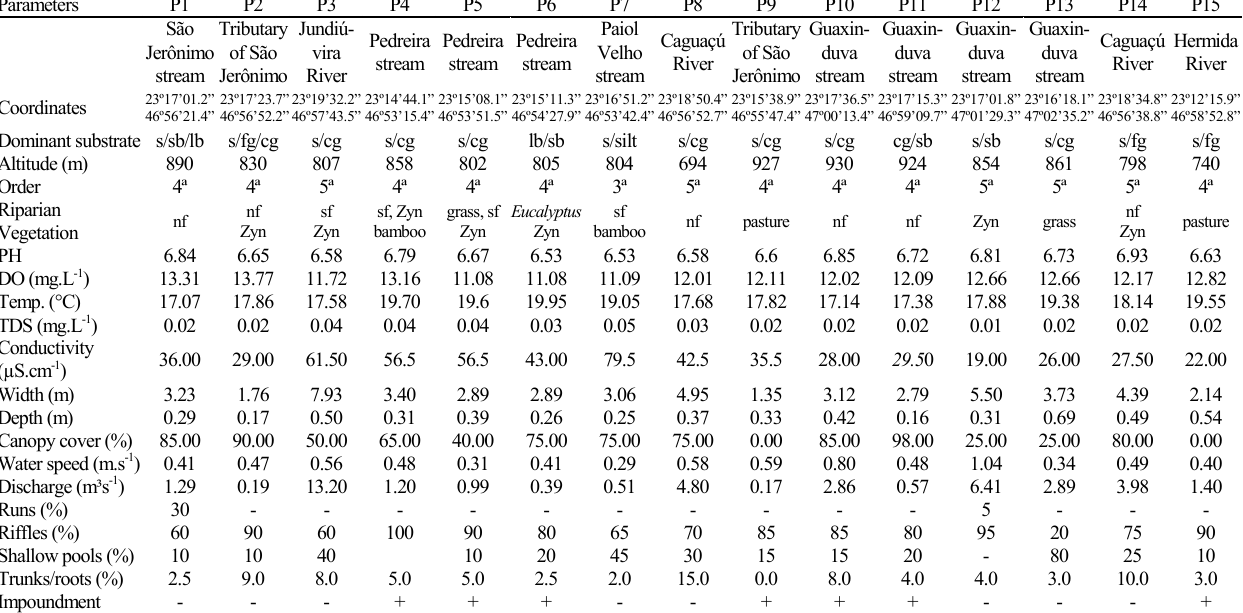
Table 1. Main characteristic and physicochemical water parameters (average values - rainy and dry season) in 15 sites of the Serra do Japi streams (APA Cabreúva and Jundiaí). DO= Dissolved oxygen; TDS= Total Dissolved Solids; s=sand; fg= fine gravel; cg= coarse gravel; sb= small boulder; lb= large boulder ; nf= native forest; sf= secondary forest; Zyn= Zyngiberaceae (+) presence; (-)